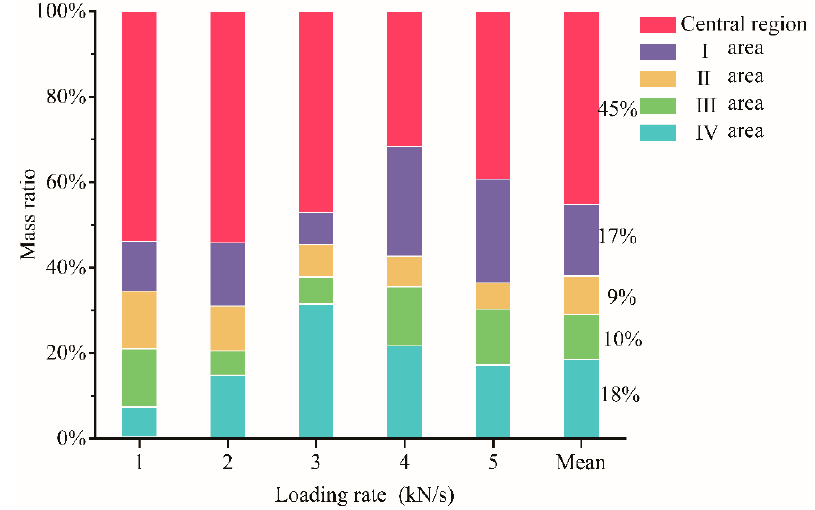
Figure 8. Mass distribution of fragments partition.